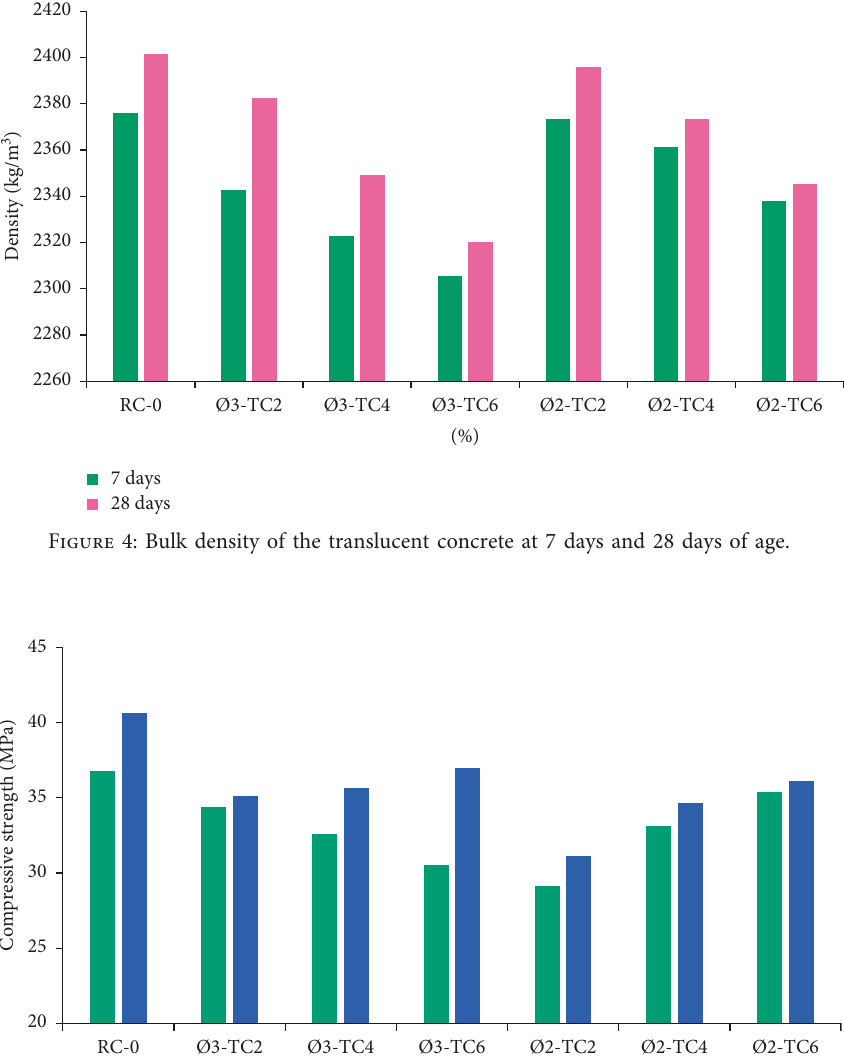
Table 9. The bending stress-strain and normal stress-strain of the POF-reinforced concrete and RCP are shown in Figures 8 and 9, respectively.